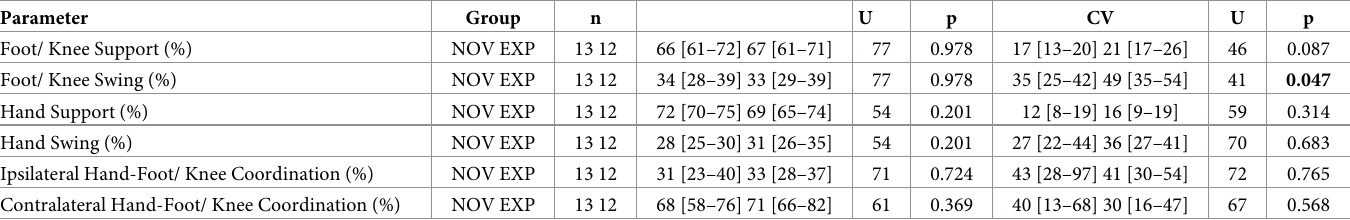
Table 2. Results about hand and foot/ knee ground contact temporal parameters. This table presents the median [Q1-Q3] and coefficients of variation (CV) for tempo- ral parameters of both novice (NOV) and experienced (EXP) groups. The p-values from U Mann-Whitney tests comparing both groups are given. The significant p-value is written in bold